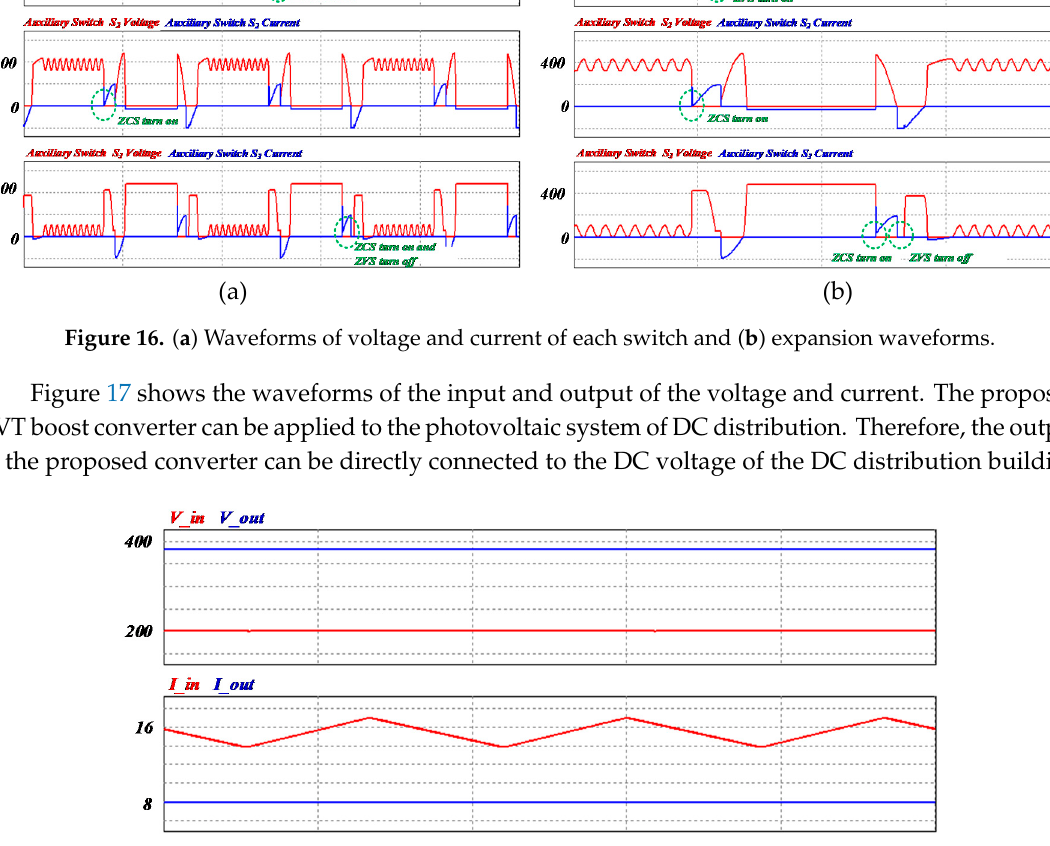
Figure 17. Waveforms of input/output voltage and current.